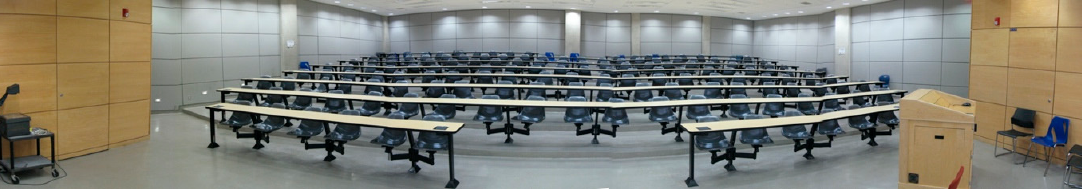
Figure 1. Geometric Visualization of the monitored building from eQUEST and DesignBuilder interfaces.